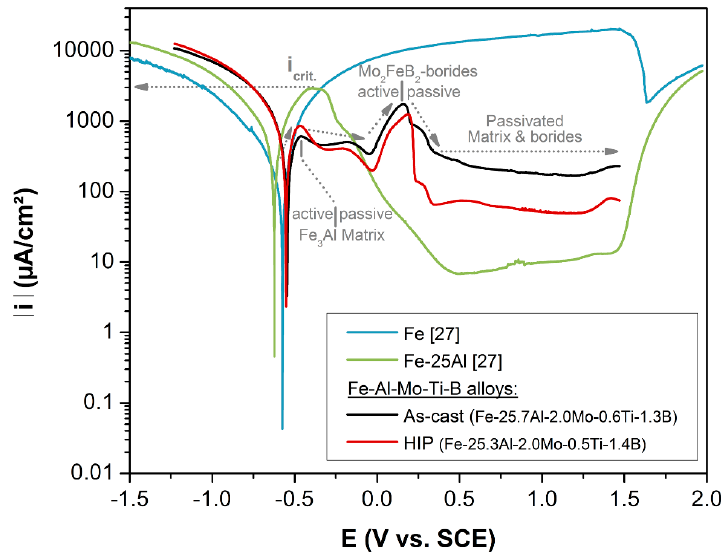
Figure 4. Potentiodynamic curves measured in sulphuric acid solution (pH = 1.6) at room temperature. Results from pure Fe and binary Fe-25Al are added for comparison [28].